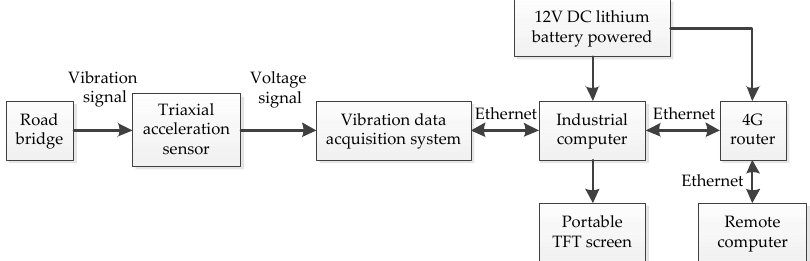
Figure 15. Schematic diagram of bridge site data collection environment.